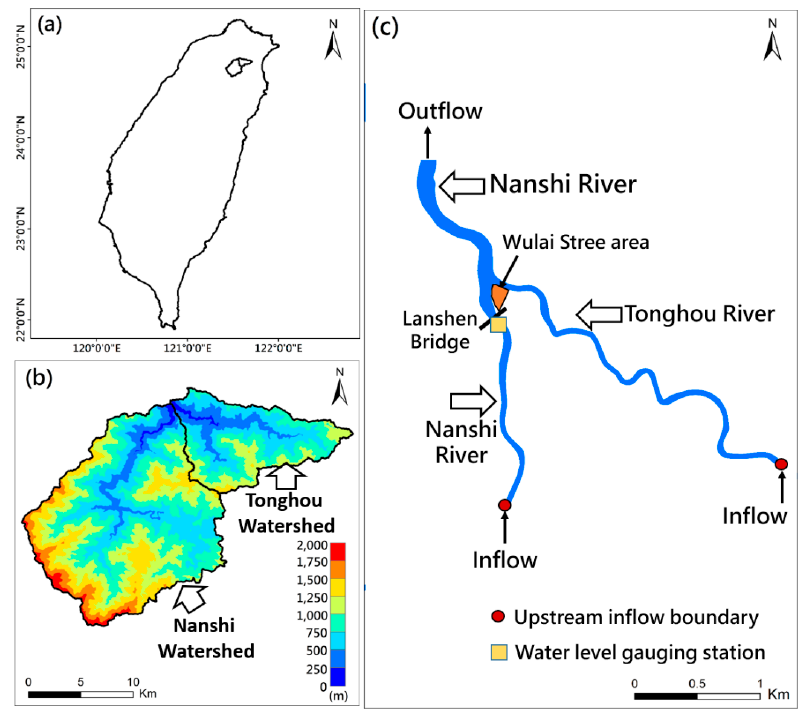
Figure 1. Locations of the study area: ( a ) country, ( b ) watersheds, and ( c ) rivers.